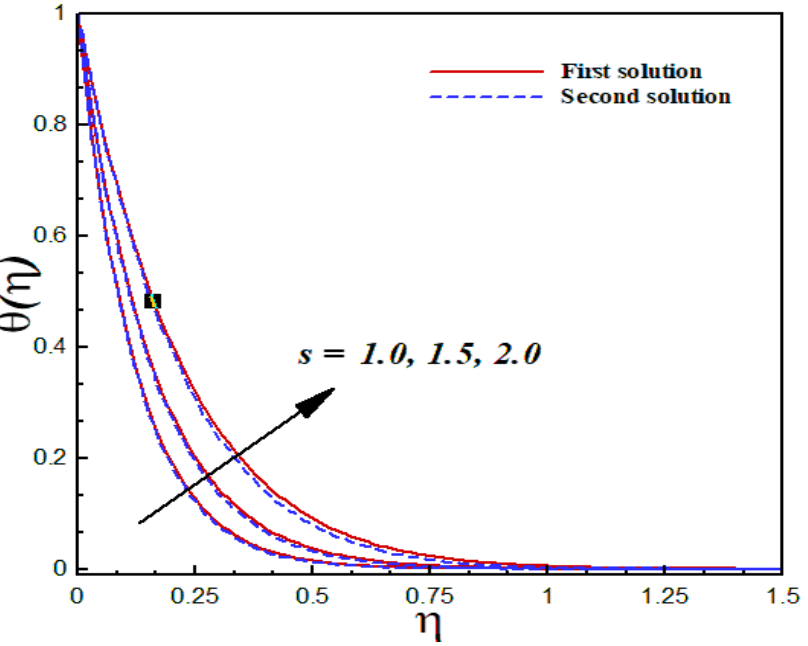
Figure 18. Temperature profiles θ ( η ) for distinct s when λ = − 1.5, k 1 = 1 = γ , δ = − 2, ϕ 1 = 0.1 = ϕ 2 , Pr = 6 . 2 .